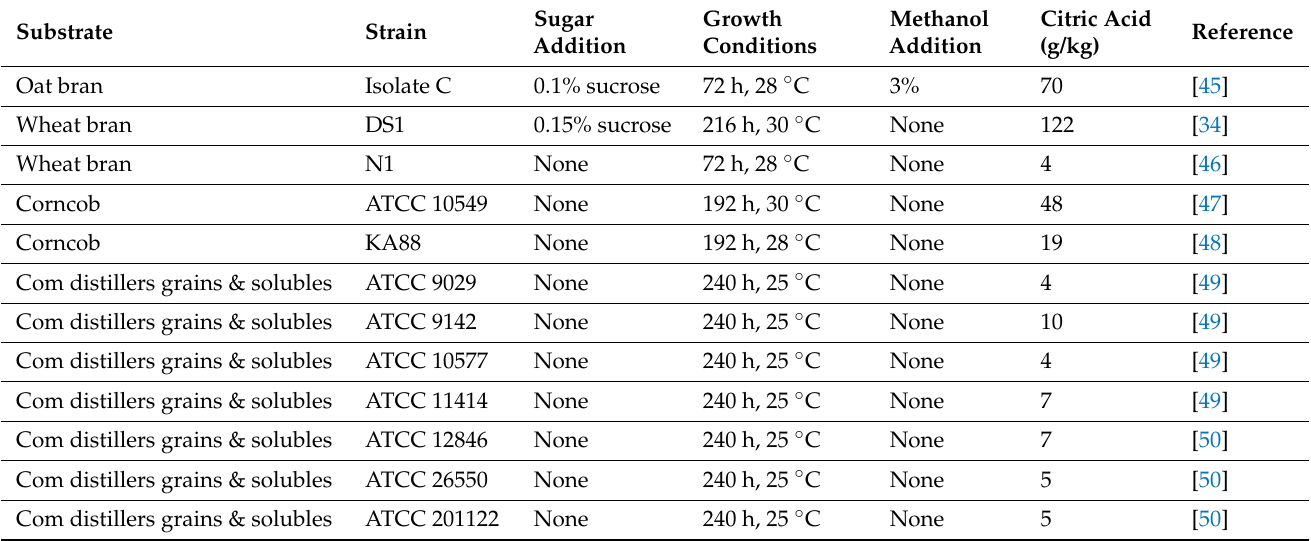
Table 4. Growth conditions and maximum citric acid production by Aspergillus niger strains on cereal grain processing coproducts utilizing solid-state